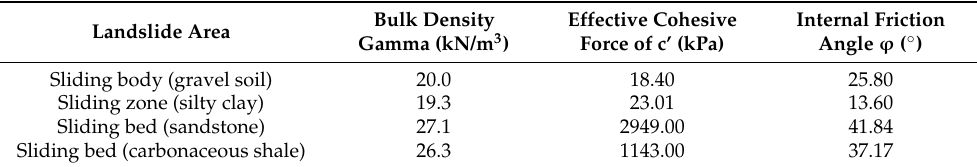
Table 5. Physical and mechanical parameters of rock and soil mass in the Siwan village landslide of Profile 2-2.